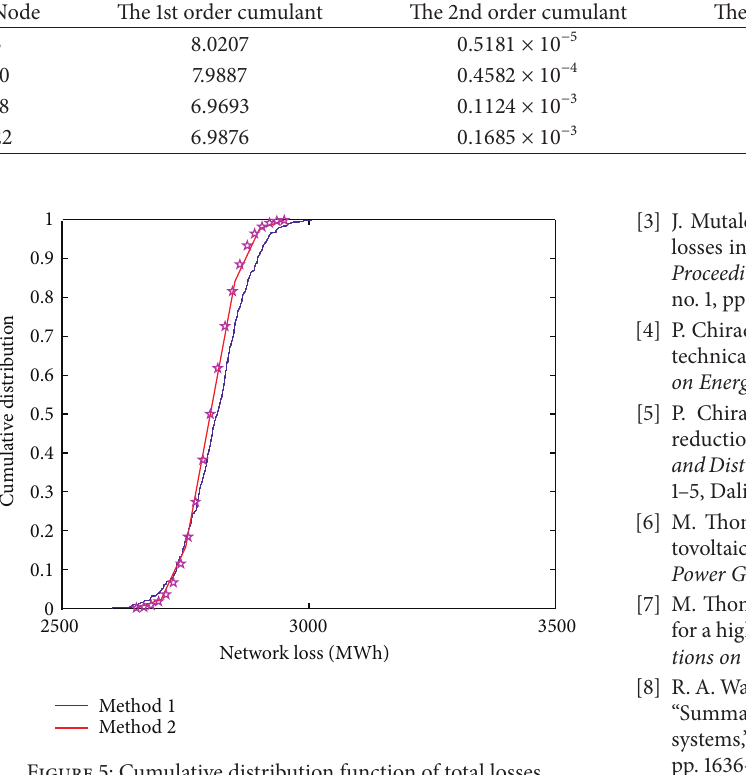
Figure 5: Cumulative distribution function of total